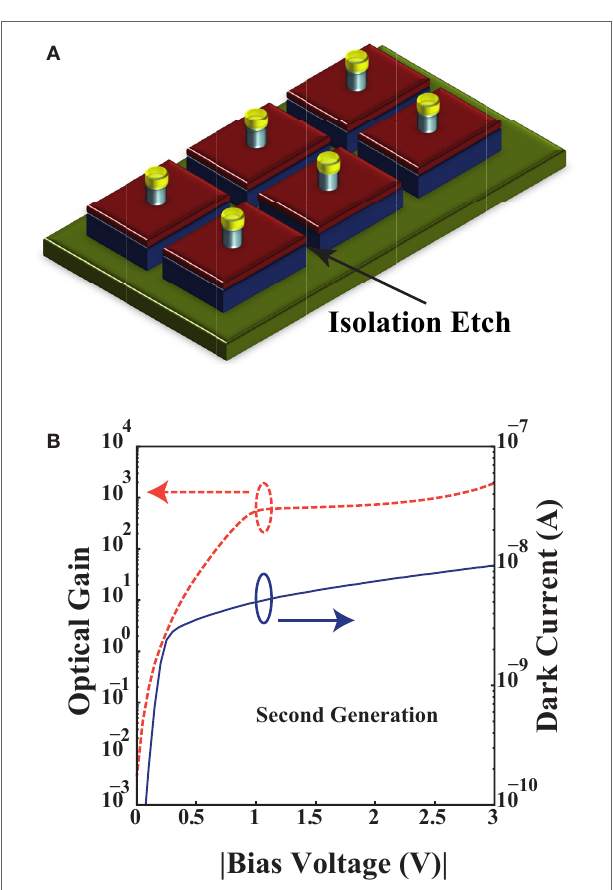
FiGURe 9 | (A) Schematic diagram of second-generation of electron- injection detectors. (B) Plots of second-generation electron-injection detector characteristics in log scales: dark current and optical gain versus bias voltage characteristic at room temperature. Detectors have 10 μ m injector diameters and 30 μ m absorber diameters. Please note that a negative bias is applied to the injector and (B) shows the magnitude of bias voltage (Fathipour et al.,